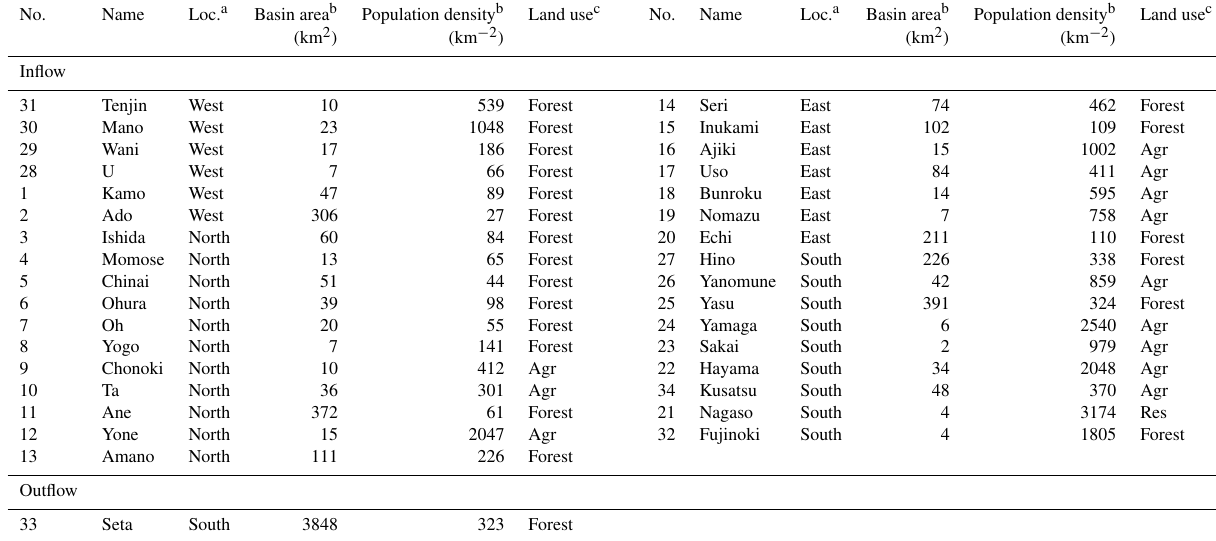
Table 1. List of studied streams.